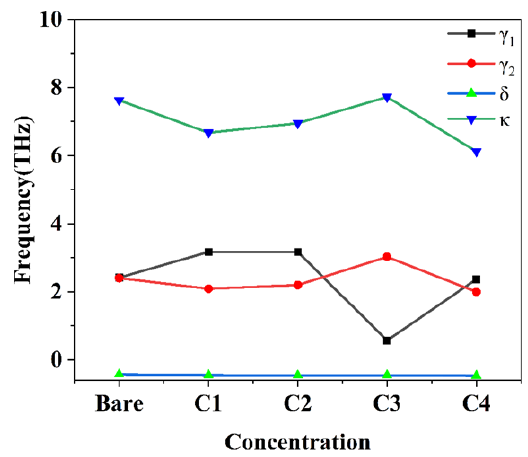
Figure 7. The resonance parameters 𝛾 1 , 𝛾 2 , δ , and κ with OVA concentration obtained by fitting the transmission spectra in Figure 4a.